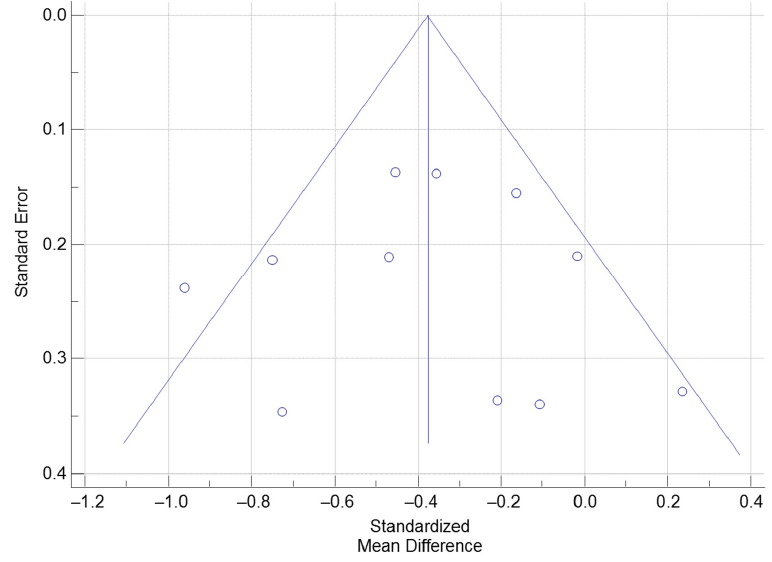
Figure 3. Funnel Plot examining trials of PTH responses with vitamin D supplementation.